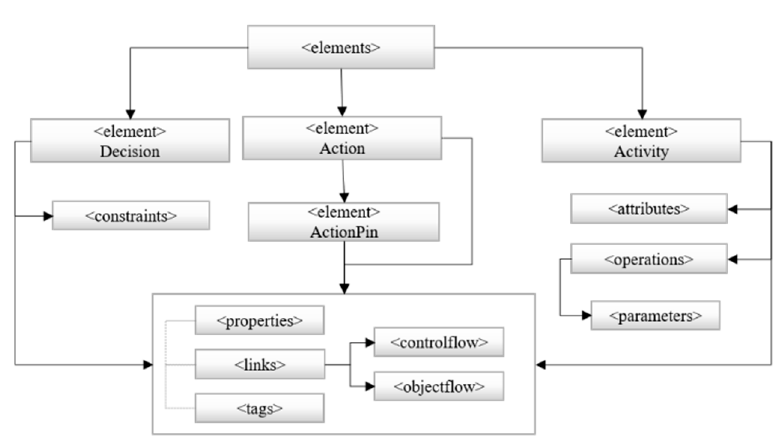
Figure 3. A high-level XML ElementTree schematic diagram.